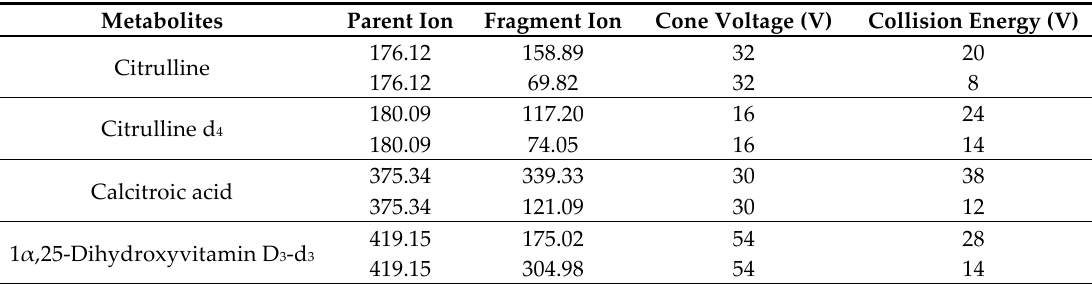
Figure 1. The overall urinary metabolomic profile in mice after exposure to four types of radiation. ( A ) singular value decomposition-based principle component analysis (PCA) constructed in R showing the distinct separation of the metabolomic profiles of control mice ( red circles) from that of mice exposed to ionizing radiation (IR) using the ions present in at least 70% of the samples. This PCA also highlights the similarities in the metabolomic signatures of the 4 exposure types; X-ray irradiation at 1.1 Gy/min (HDR) ( dark blue circles), X-ray irradiation at 3.0 mGy/min (LDR) ( yellow circles), internal 137 Cs ( purple circles), and internal 90 Sr ( light blue circles). While the metabolomic signatures of 90 Sr and 137 Cs exposures match each other more closely, they do overlap with HDR and LDR X-ray irradiations; ( B ) Venn diagram showing the distribution of statistically significant metabolic pathways among the different exposure types. This diagram shows the number of Kyoto Encyclopedia of Genes and Genomes (KEGG) pathways with statistically significant perturbations after the above four IR exposures. The blue box highlights the common KEGG pathways, which had statistically significant changes in the urinary excretion of at least one of their intermediates in all four exposure scenarios. This figure shows overall metabolic perturbations (increase or decrease) in these pathways induced by all exposure types. Table 1. Experimental parameters for quantitation of citrulline and calcitroic acid in urine. For each analyte, the first transition was used as quantitative transition and the second was used as confirmatory